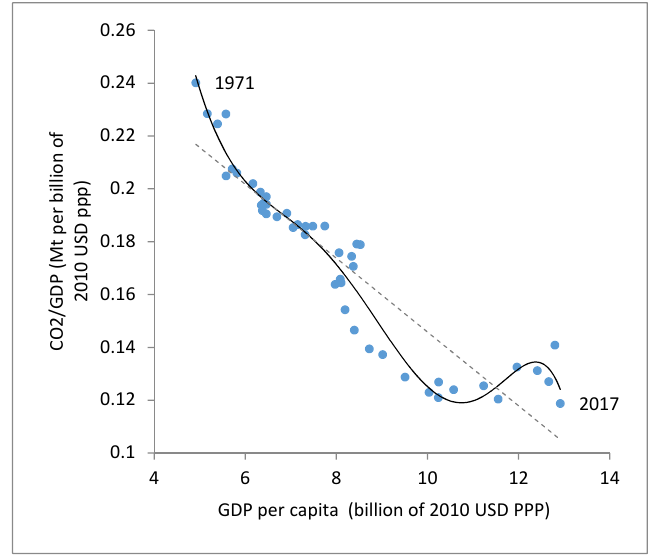
Figure 2. Relative delinking of CO 2 emissions. (Source: Produced by the authors with IEA data [4]).